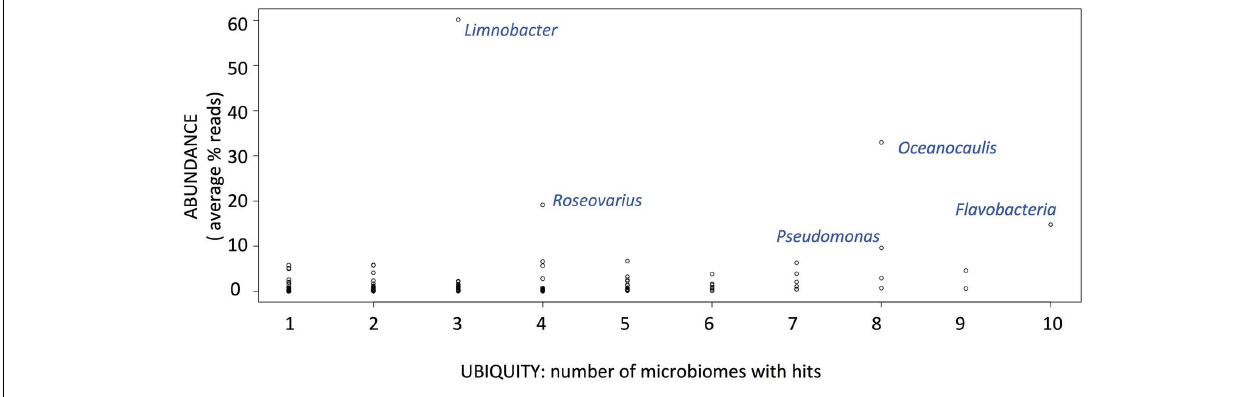
Frontiers in Microbiology | Microbial